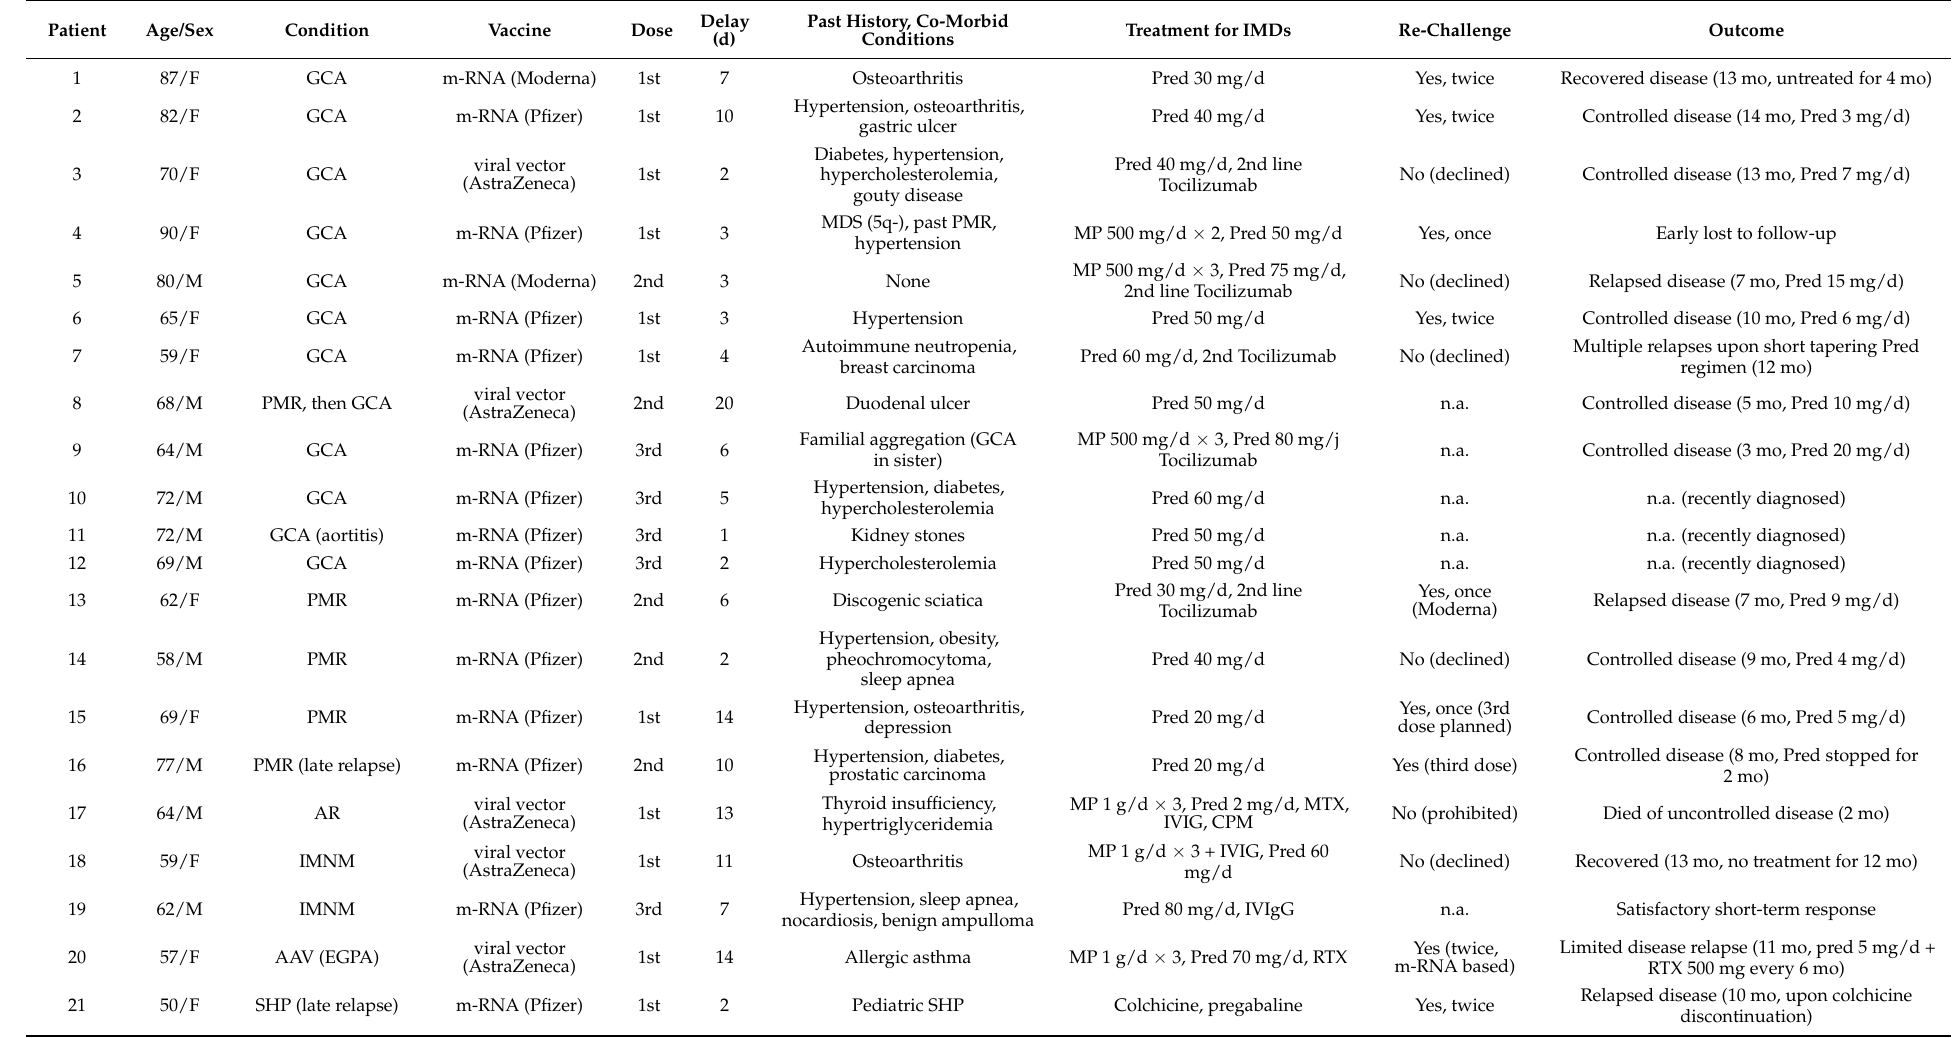
Table 1. Data of patients with immune-mediated diseases occurring, or relapsing, following COVID-19